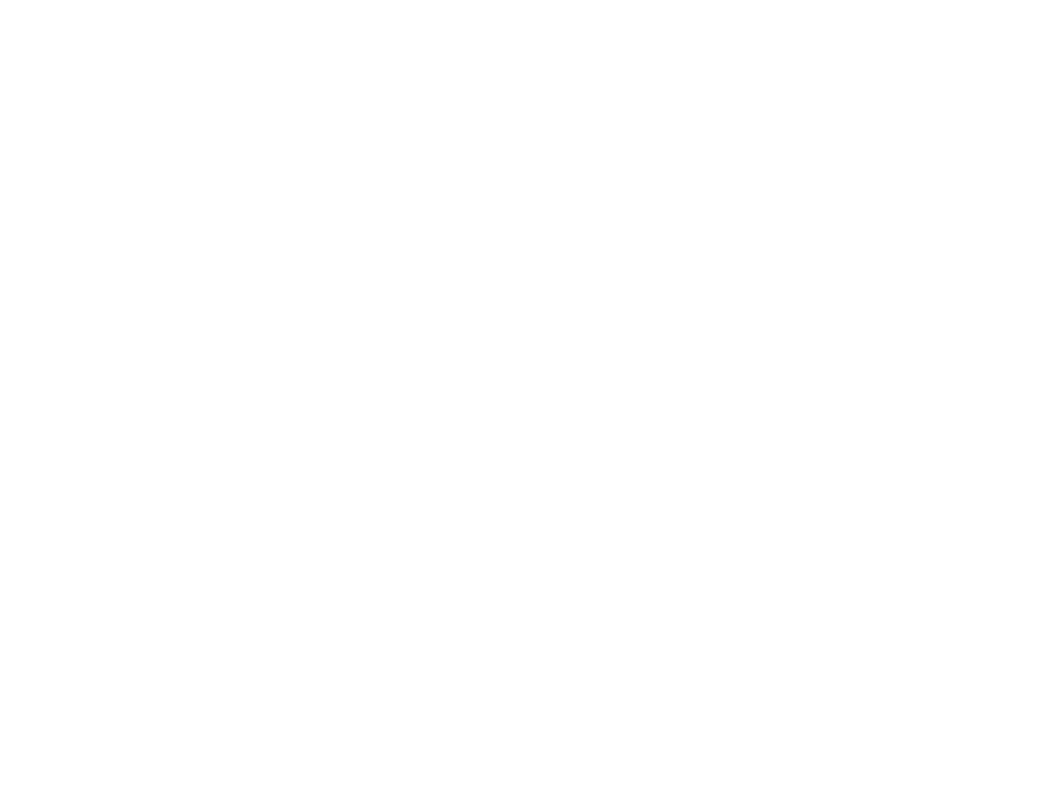
Time trends in age-standardised incidence rates (ASIRs) (European standard population) of oesophageal cancer by sex, histological subtype and language region from 1982 to 2011. NOS = not otherwise